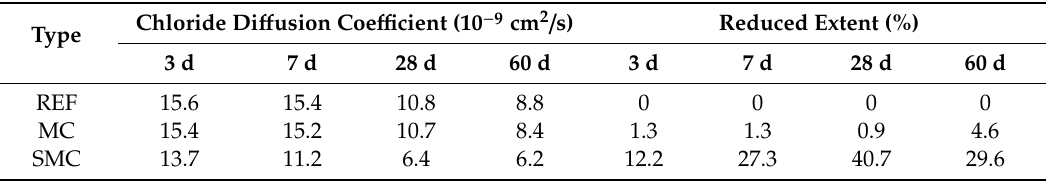
Table 4. Chloride permeability of concrete at different ages.